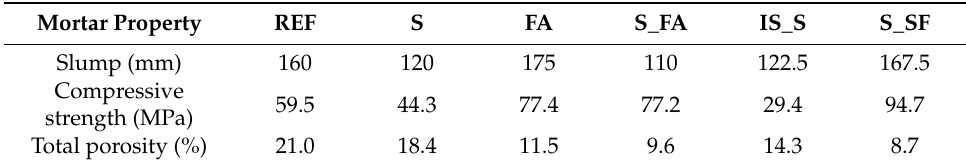
Table 3. Mortar characteristics.